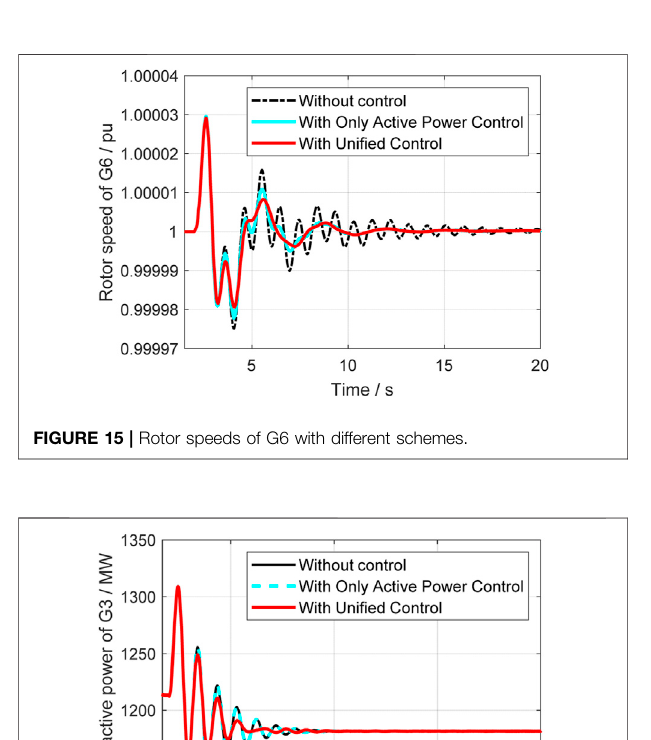
FIGURE 14 | Rotor speeds of G3 with different schemes.